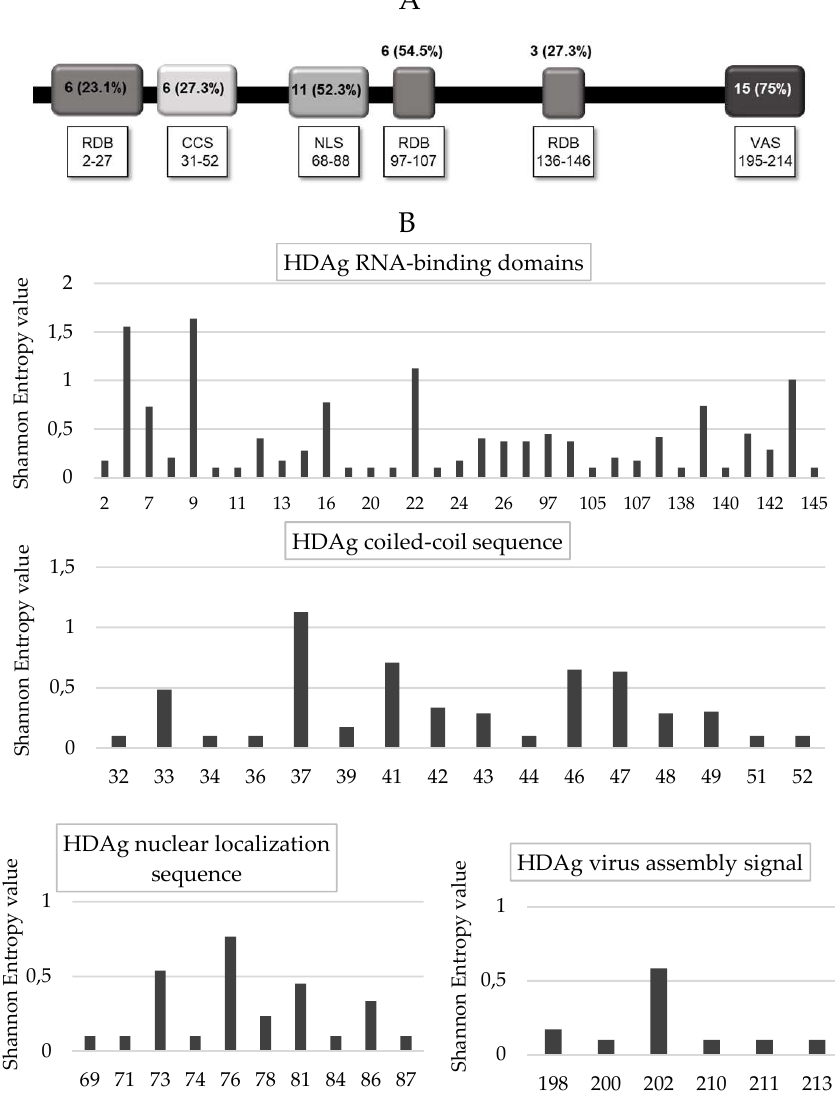
Figure 5. ( A ) Degree of HDAg conservation. The figure reports the number of conserved positions in each HDAg functional domains: RNA-binding domain (RBD), coiled–coil sequence (CCS), nuclear localization sequence (NLS), nuclear export signal (NES) and virus assembly signal (VAS). HDAg domains are defined according to Pascarella et al., 2010 [28]. ( B ) The histogram reports the Shannon Entropy (Sn) value at HDAg positions in 47 HDV genotype-1 infected patients. Conserved positions (Sn = 0) were not reported in the histogram. Shannon Entropy was calculated according to the following formula Sn = − Σ i(pi lnpi)/lnN) where pi was the relative frequency of each distinct amino acid detected at a given position and n was the total number of sequences